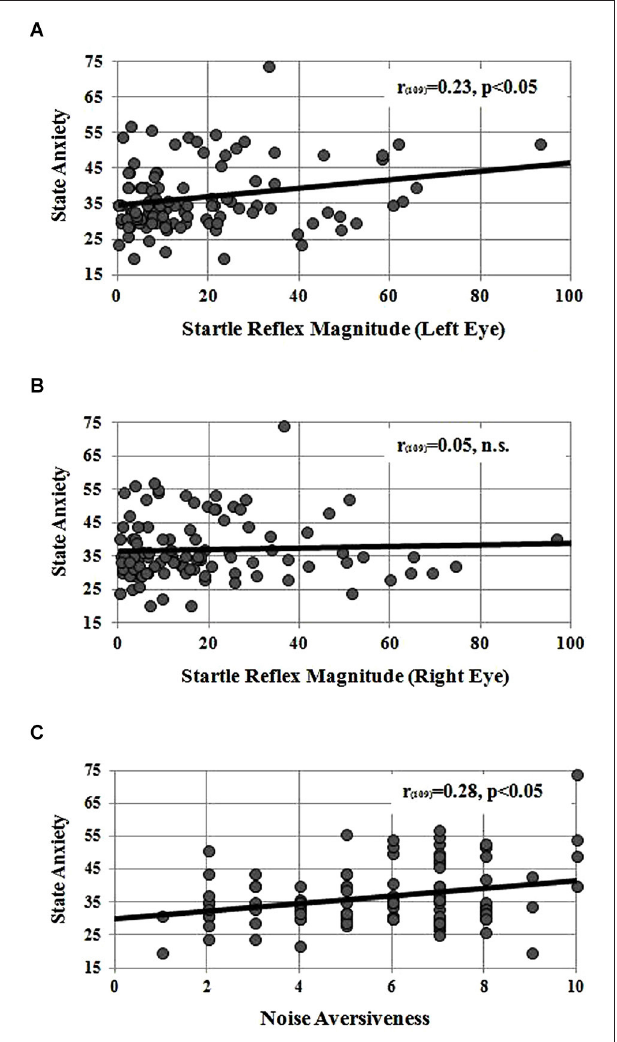
FIGURE 1 | Panel (A) correlation between startle reflex magnitude, measured in microvolts below the left eye, and the State Anxiety raw score measured at the end of the experimental session . Panel (B) correlation between startle reflex magnitude measured from the right eye and the State Anxiety raw score. Panel (C) correlation between state anxiety raw score and the subjective noise aversiveness measured on a 0–10 analog